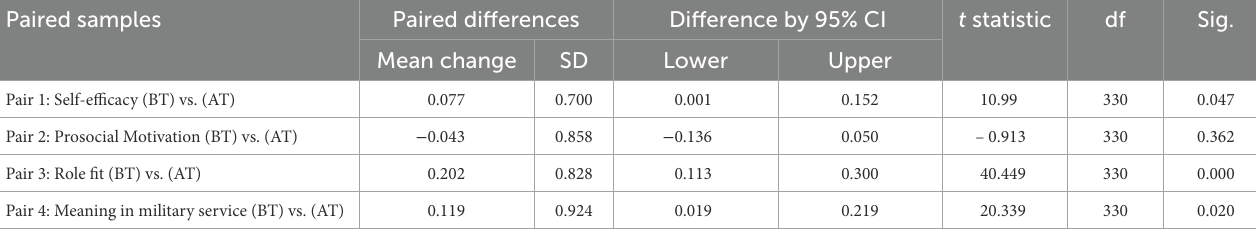
TABLE 3 Paired differences between study variables identified by paired samples t -test. Paired samples Paired differences